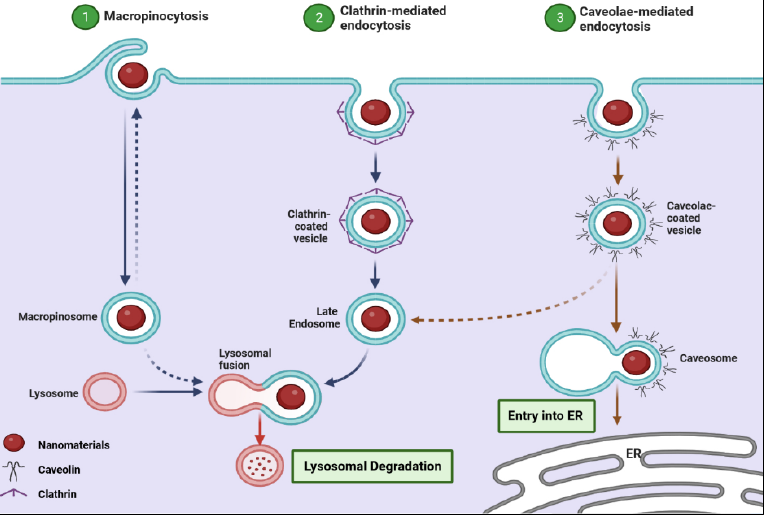
Figure 5. Three main mechanisms of endocytosis by which nanomaterial can enter cells. Abbreviation: ER—endoplasmic reticulum.